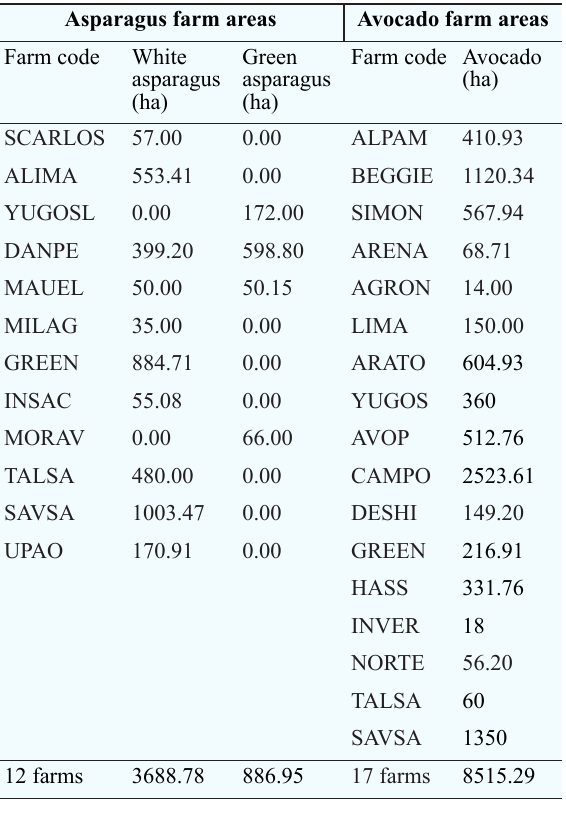
Table 1. Production areas of asparagus and avocado fields of the Chavimochic irrigation project in December 2017.